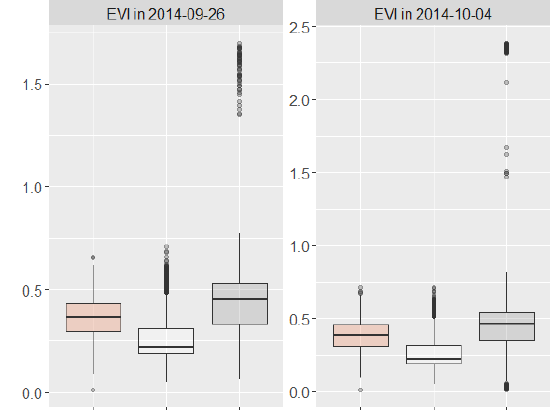
Figure 6. Boxplots of the two most important variables for each class in the season 2014 –